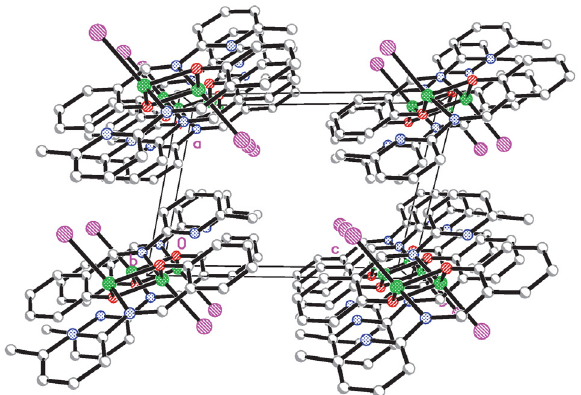
Figure 2. Molecular packing structure of complex 1